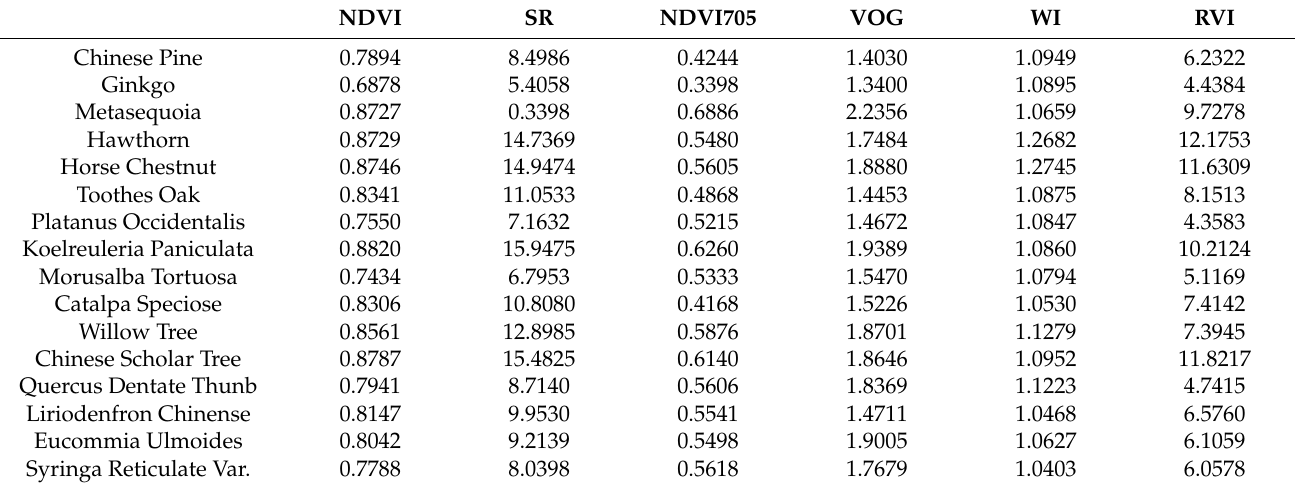
Table 5. Vegetation spectral indexes